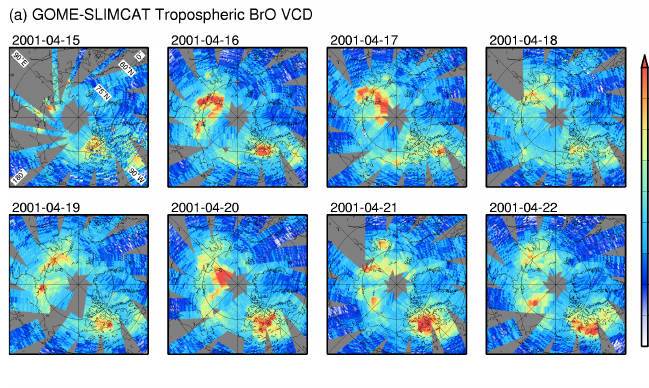
www.atmos-chem-phys.net/11/3949/2011/ Atmos. Chem. Phys., 11, 3949–3979,